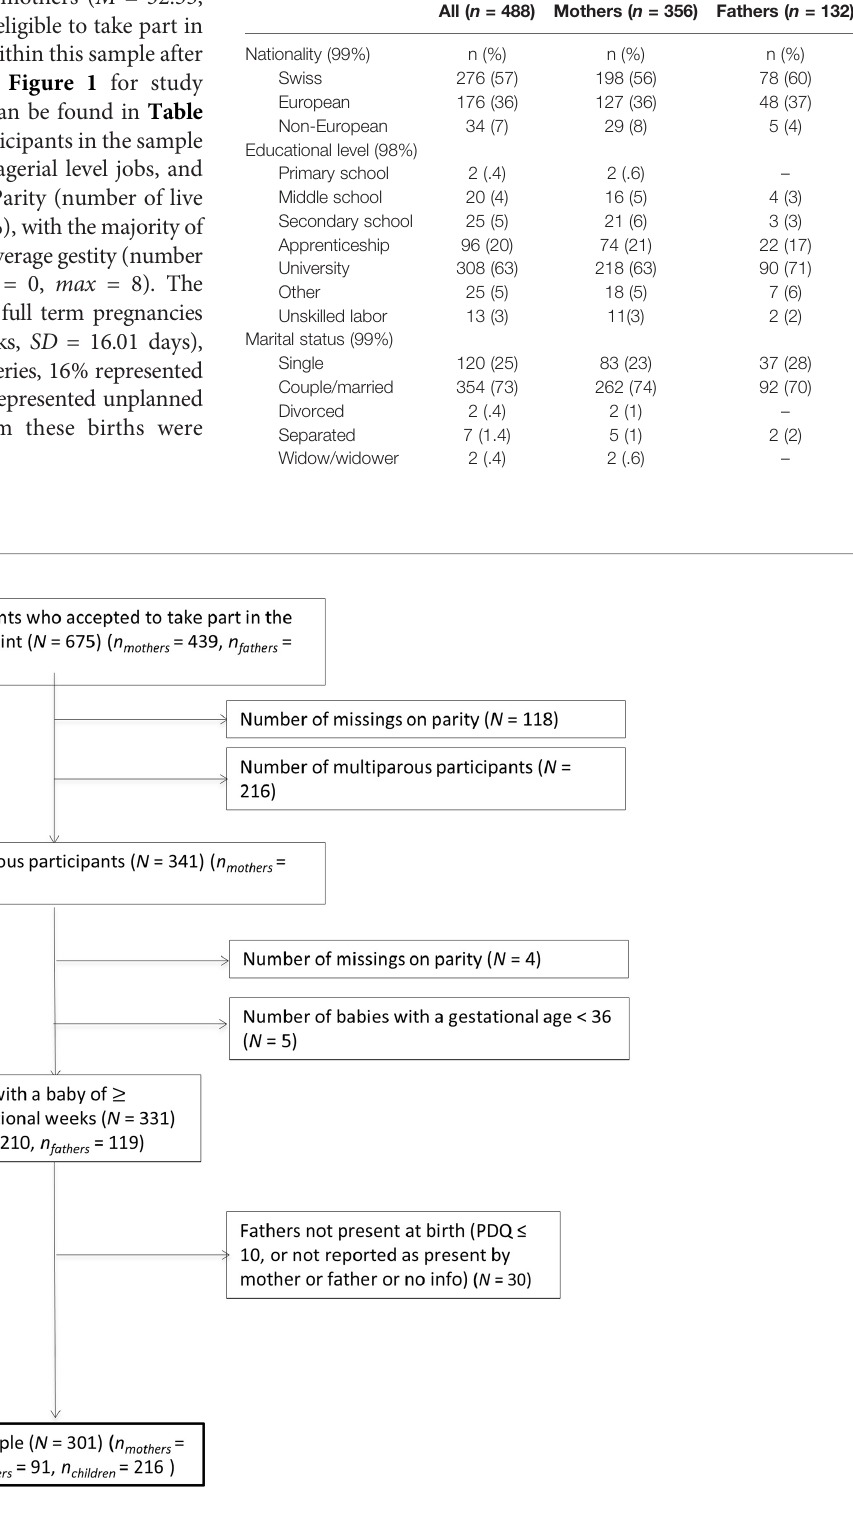
FIGURE 1 | Flow of study participants.